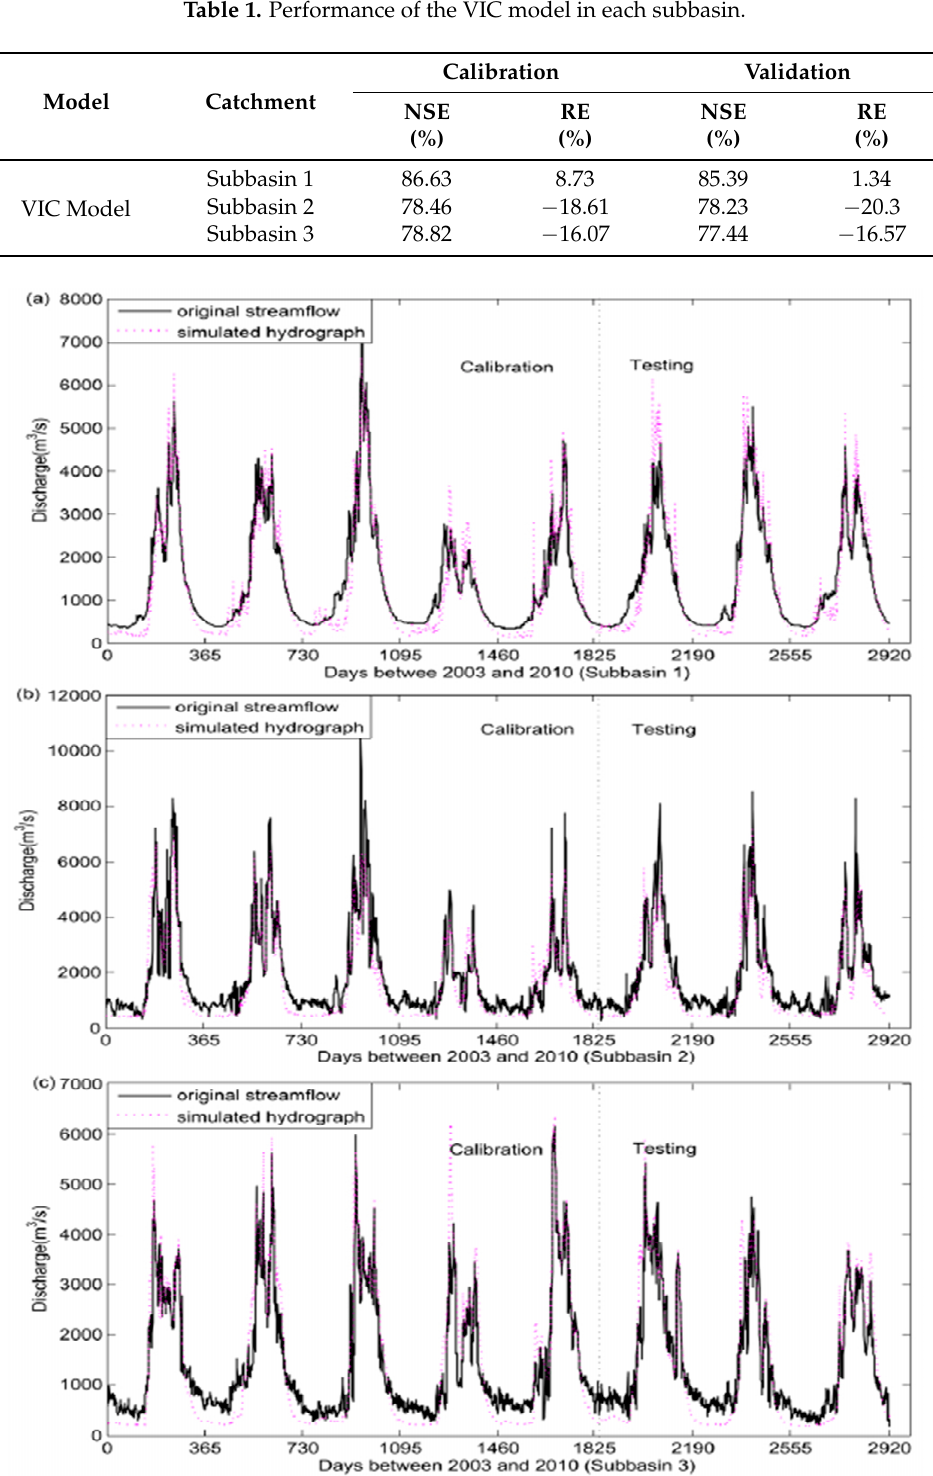
Figure 7. Comparison of the original observed streamflow and the simulated runoff hydrograph according to the three ‐ subbasin VIC model.